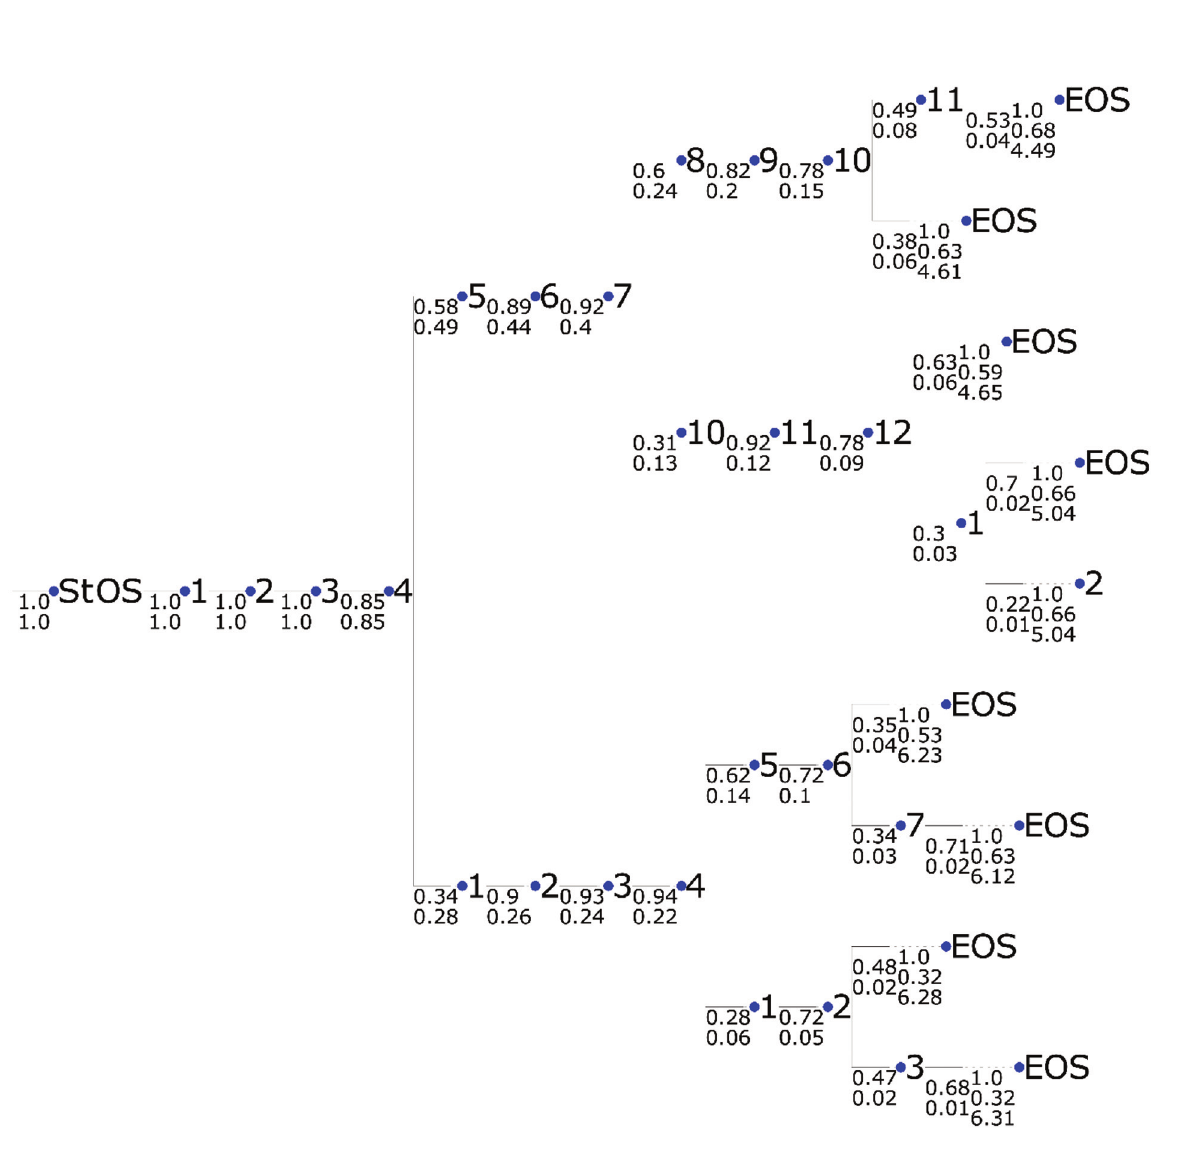
Figure 8: Output of the seq2probTree learning method for the first-order Markov